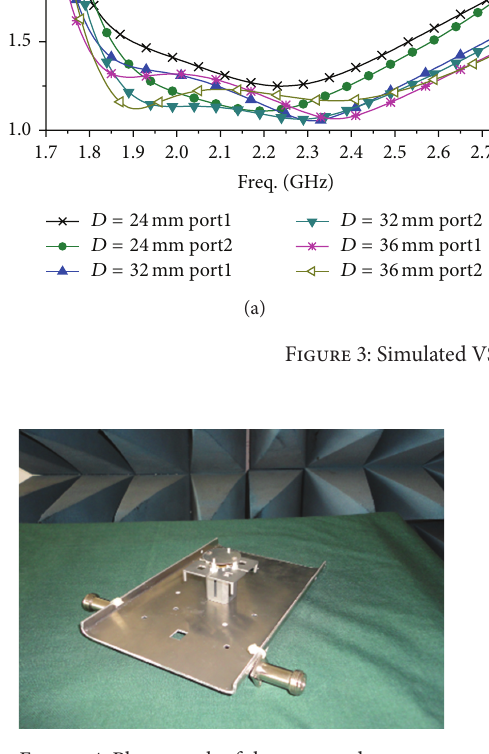
Figure 4: Photograph of the proposed antenna.